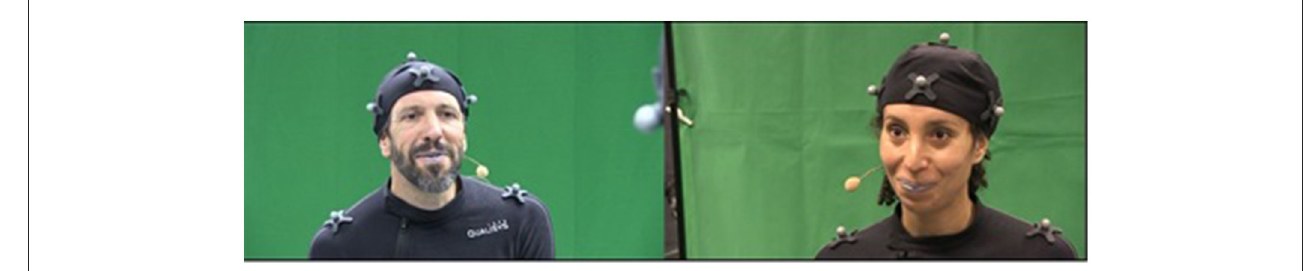
FIGURE4 Example of a face-to-face conversation recording with cameras 1 and